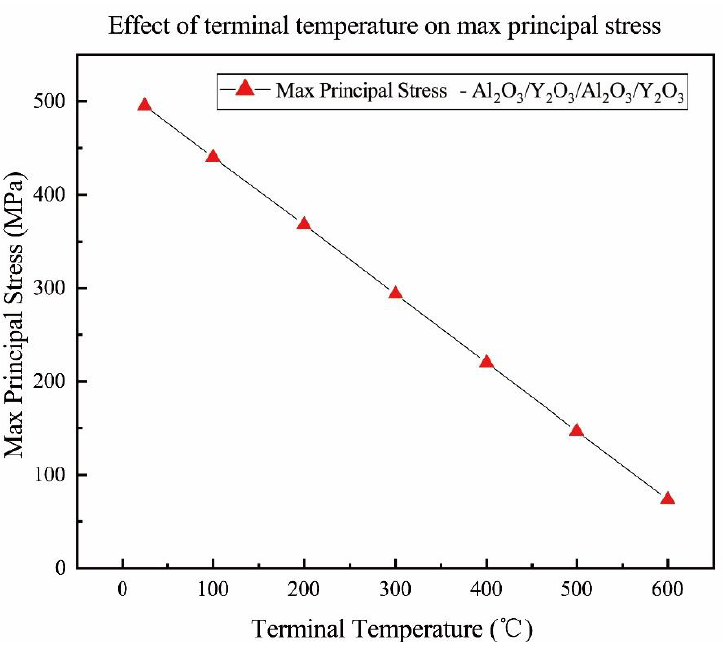
Figure 7. Effect of terminal temperature on the max principal